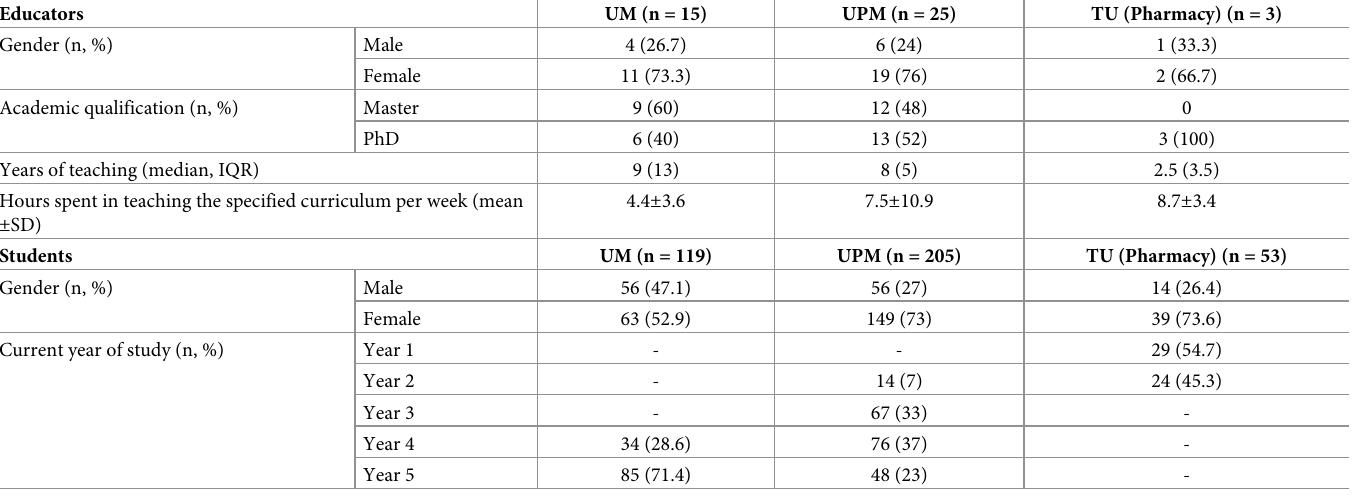
Table 2. Demography of participants (n =